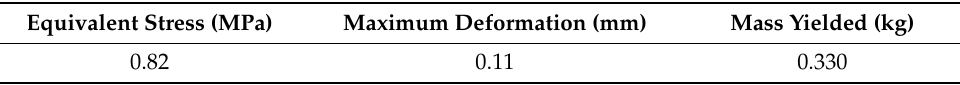
Table 3. Equivalent stress and maximum deformation for topology optimized monocoque Quad- copter